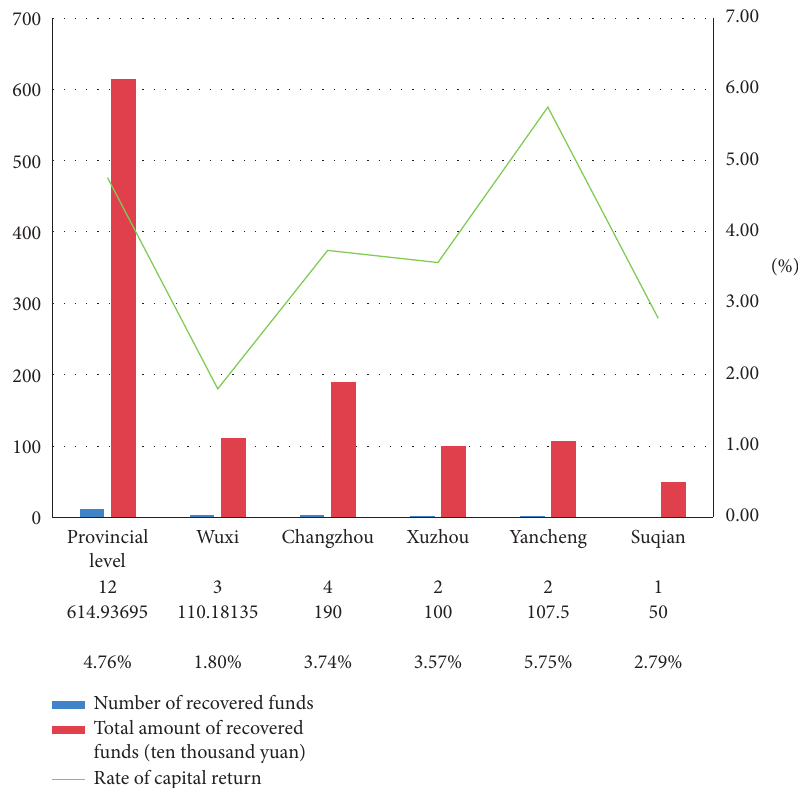
Figure 8: Fund prerecovery rate of supporting projects in various regions from 2011 to